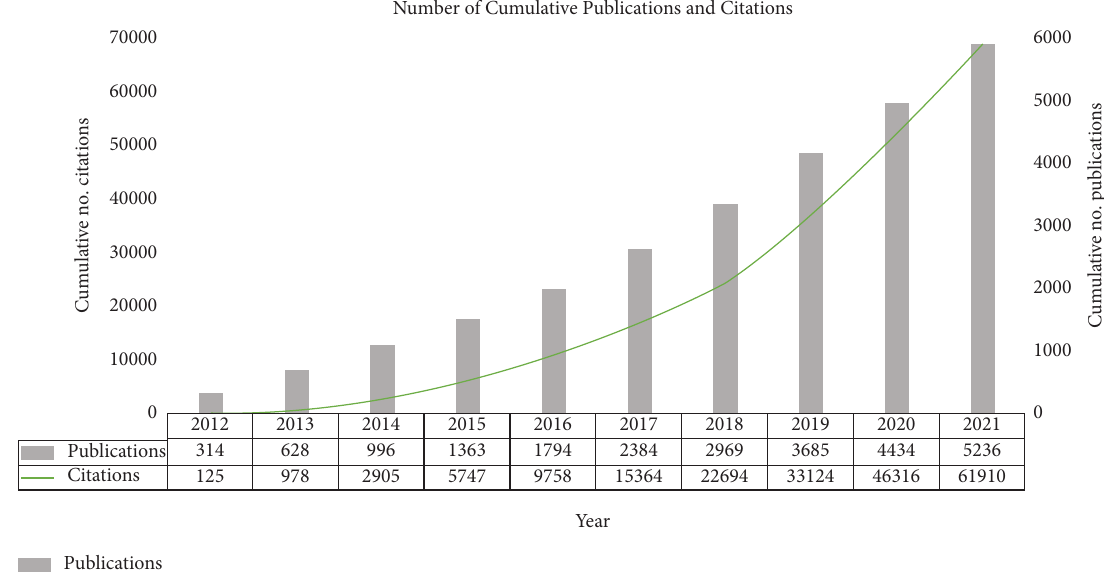
Figure 3: Cumulative numbers of publications related to acute postsurgical pain and numbers of citations to those publications, 2012–2021. Notes: the data has been taken from the publication year to the retrieved date (February 10, 2022). Linear modeling of the number of publications y = 544.2x - 1E+06 R 2 = 0.9751